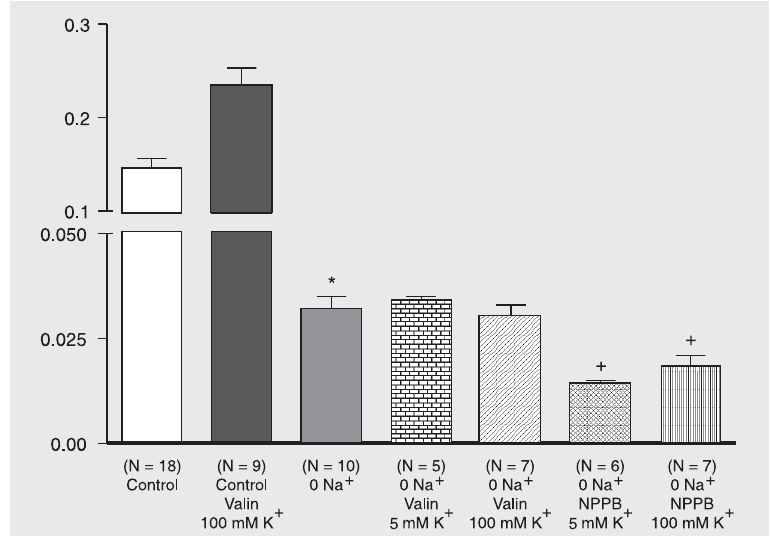
Figure 2. Effect of abolishing cell potential difference (PD) on the observed reduction of cell pH after blocking Cl - channels. Means ± SEM of dpHi/dt (pH units/min) in control (Na + Ringer) and 0 Na + Ringer during superfusion with 10 µM valinomycin (valin)/100 mM K + and/or 0 Na + /10 µM 5-nitro-2 (3-phenylpropylamine)-benzoic acid (NPPB). *P < 0.05 vs control; + P < 0.05 vs 0 Na + (ANOVA).